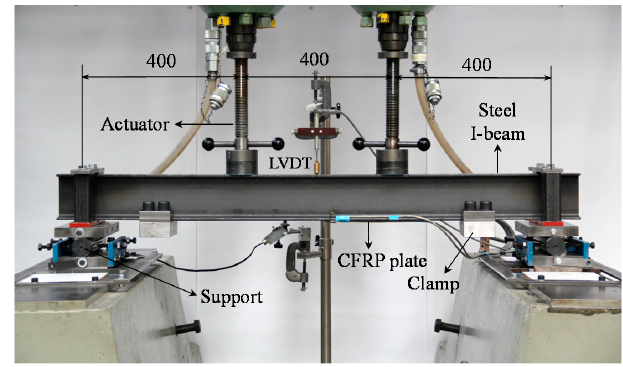
Figure 5. Four-point bending test set-up (dimensions in mm).